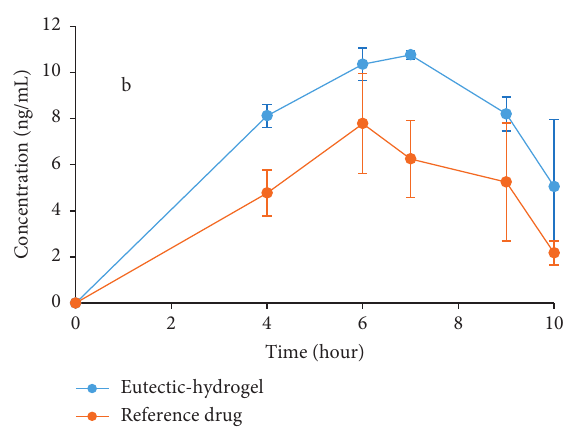
Figure 5: Progesterone content in rabbit plasma after applying the transdermal